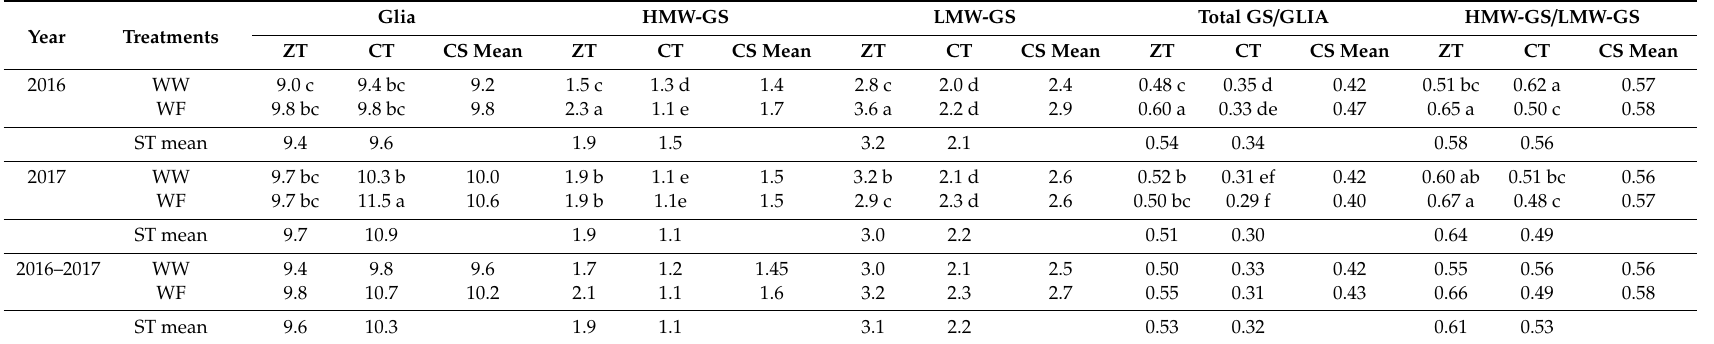
Table 5. Gluten fractions (mg g − 1 flour) (Glia: gliadins; HMW-GS: high molecular weight glutenins; LMW-GS: low molecular weight glutenins; Total GS-: HMW-GS + LMW-GS) and their ratios as recorded at harvest in the 2016 and 2017 cropping seasons. Means followed by di ff erent letters (upper case letters: main e ff ects; lower case letters: e ff ects of interaction) significantly di ff er according to Tukey’s HSD test ( p < 0.05). Treatments: CT, conventional tillage; ZT, zero tillage; WW, durum wheat monocropping; WF, durum wheat-faba bean